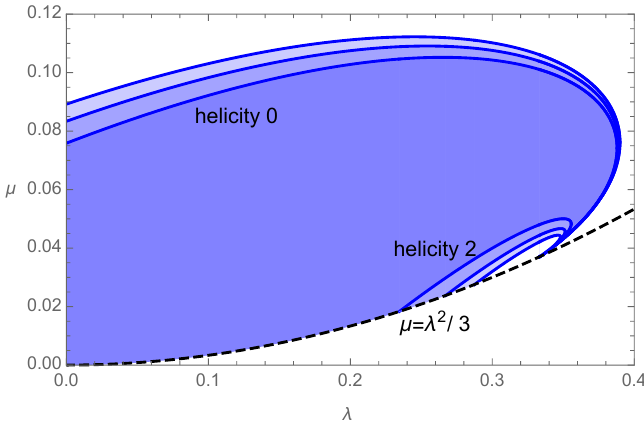
Figure 1. Shadowed blue indicates the allowed regions by causality for Lovelock parameters in 7, 8 and 9-dimensions which grow as dimensionality